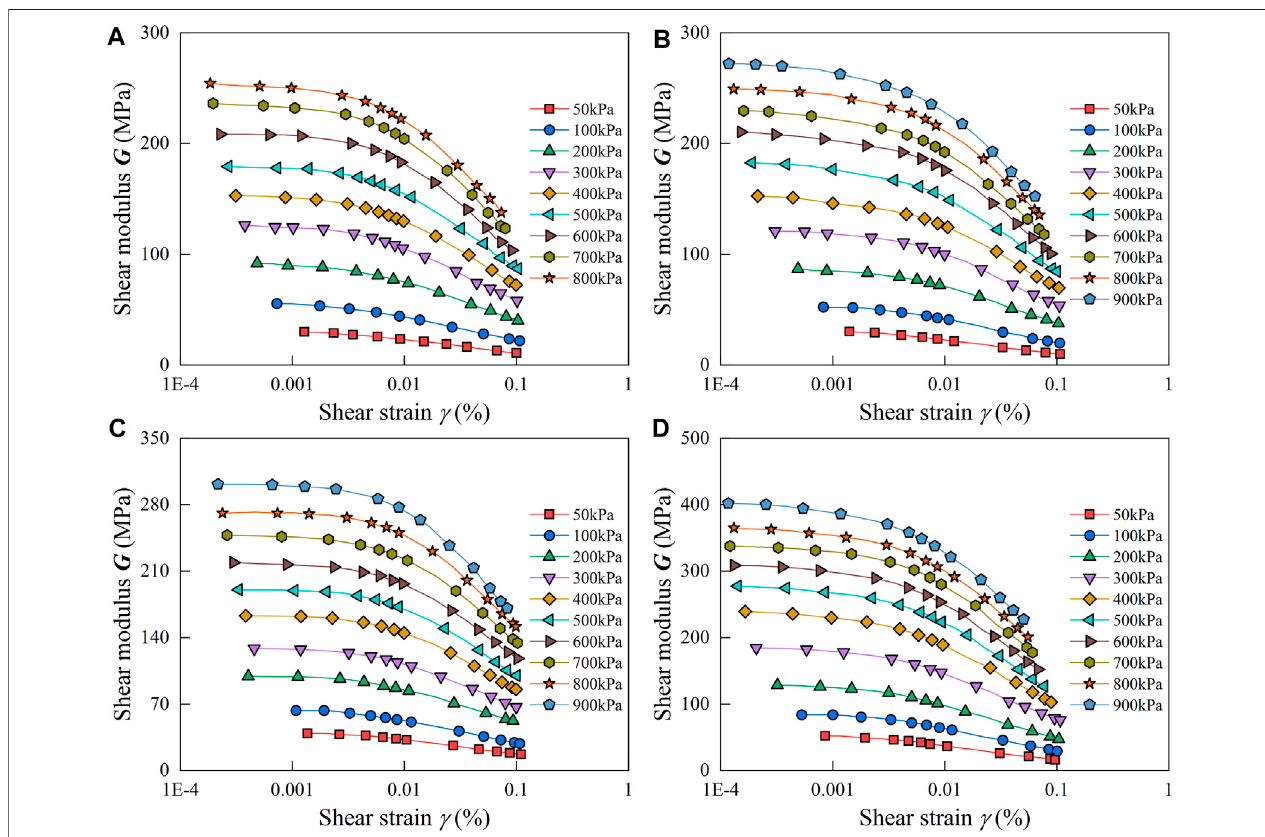
FIGURE 7 | Relationship between shear modulus G and shear strain γ for specimens in different weathering conditions: (A) CWG A; (B) CWG B; (C) HWG A; (D) HWG B (Data points halved).